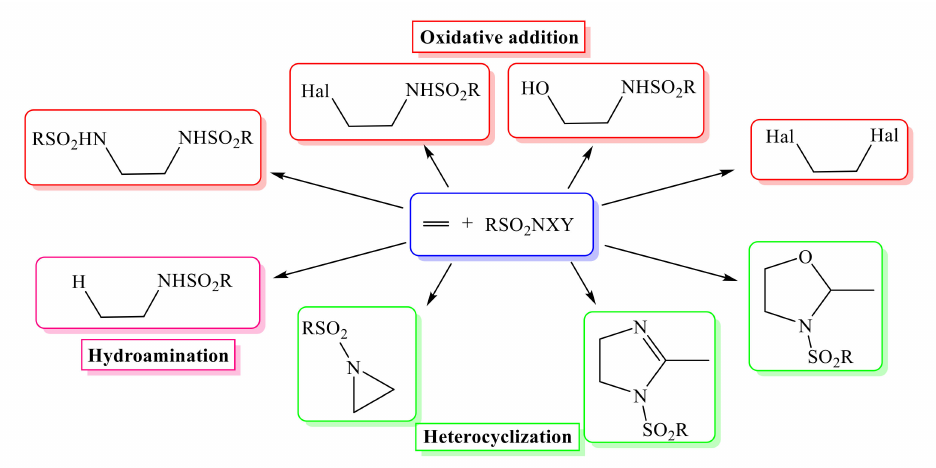
Scheme 1. Versatile reaction pathways of alkenes with sulfonamide